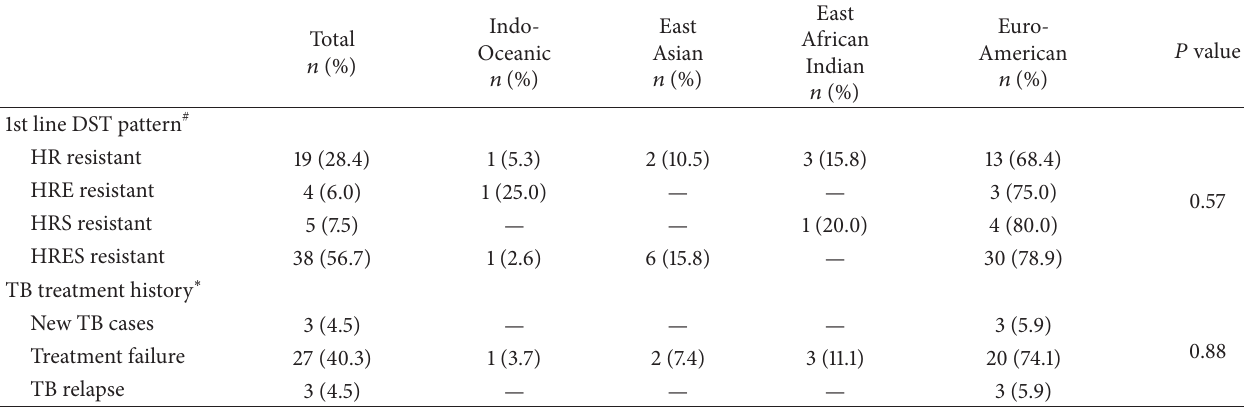
Table 3: MTB strain lineages stratified by 1st line DST and TB treatment